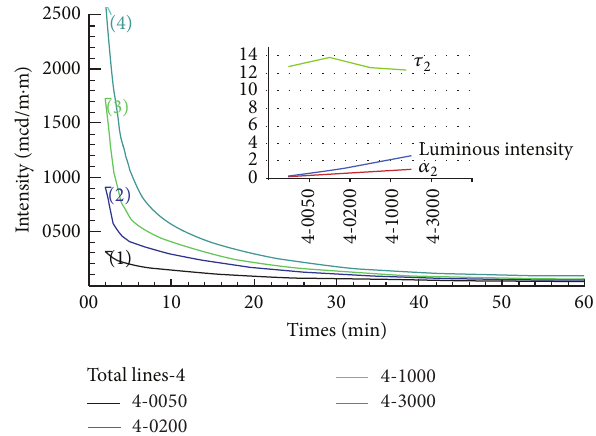
Figure 4: Afterglow profiles of the 0.4 mm thickness patch where the luminous intensity is measured at 2min.